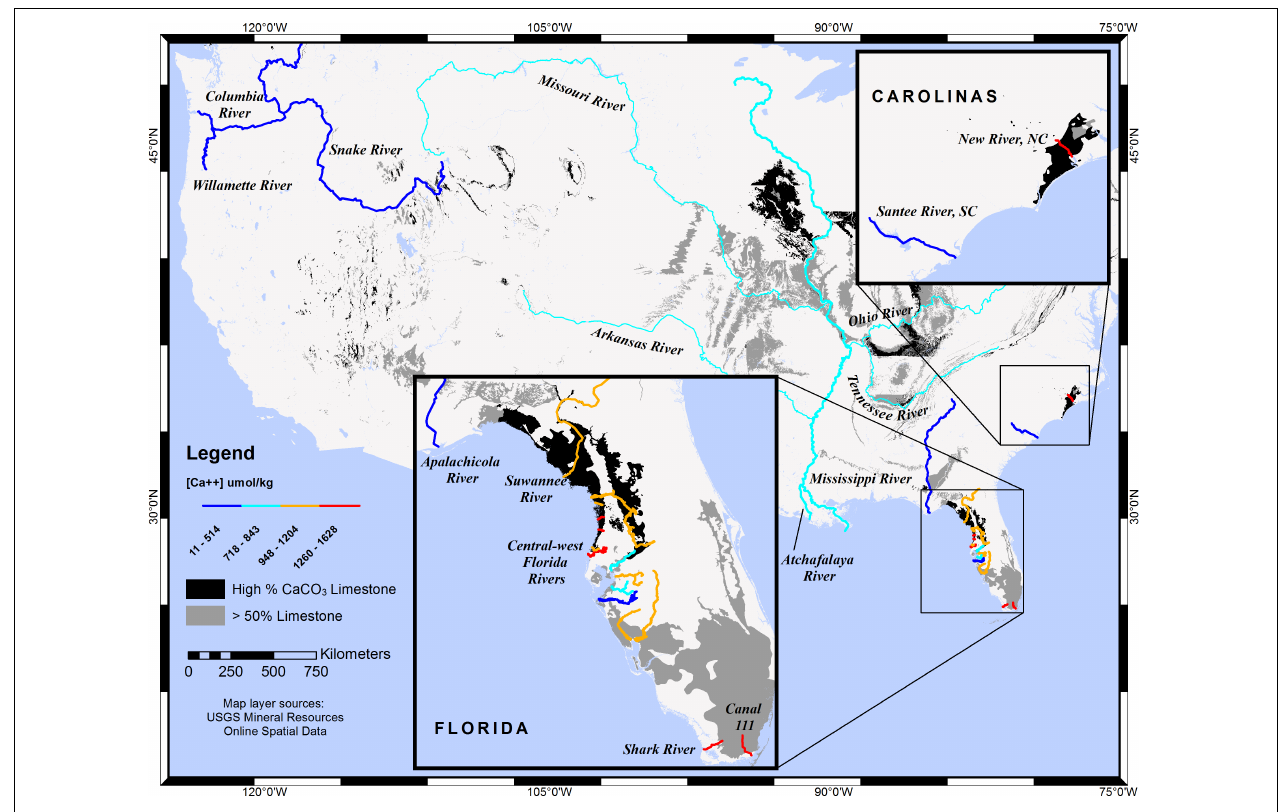
FIGURE 1 | Map of selected rivers in the conterminous United States showing riverine calcium concentrations and limestone lithology. Rivers with low calcium concentrations traverse few to no limestone substrata, while rivers with high [Ca 2 + ] traverse substrata composed primarily of limestone rock: dark gray areas symbolize rock that is primarily limestone ( > 50%) with a secondary rock type that is non-CaCO 3 , while black areas symbolize main rock composed of limestone-dolostone, limestone-calcarenite, or exclusively limestone. Although rivers are symbolized uniformly along their entire lengths and tributaries are generalized, [Ca 2 + ] characterizations were determined from a single downstream sampling station. The limestone layer map was adapted from the USGS Geologic map of the conterminous United States (Schweitzer,